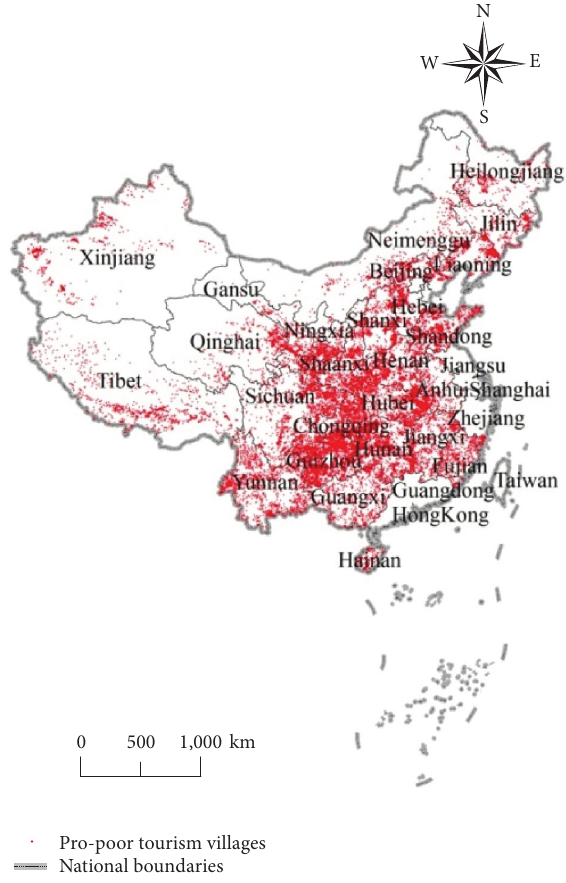
Figure 1: Distribution map of pro-poor tourism villages in